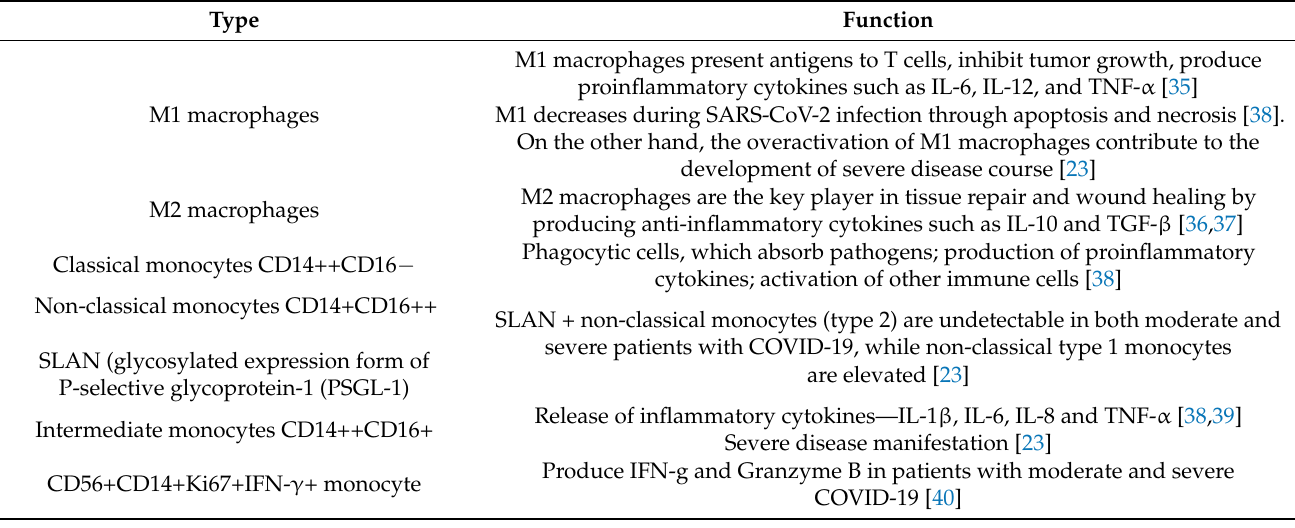
Table 3. Role of monocytes and macrophages during SARS-CoV-2 infection in children and adults